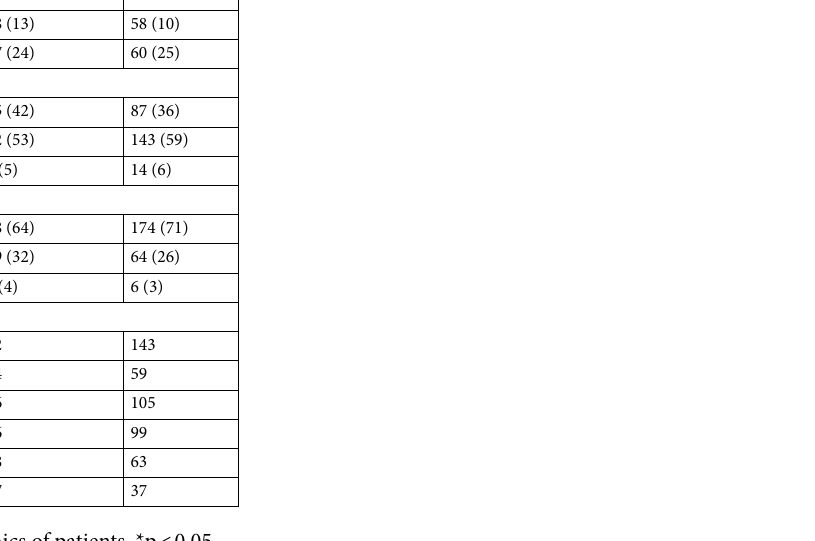
Table 1. Demographics of patients. *p <